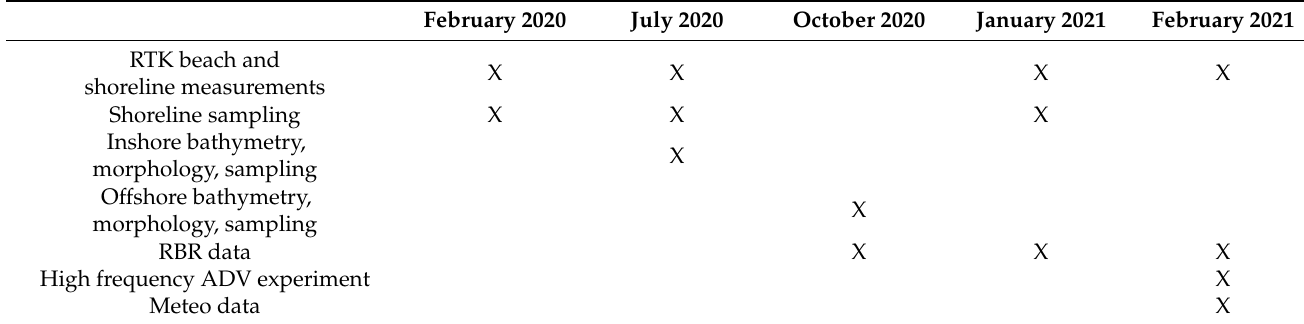
Table 1. Periods of field surveys and type of data